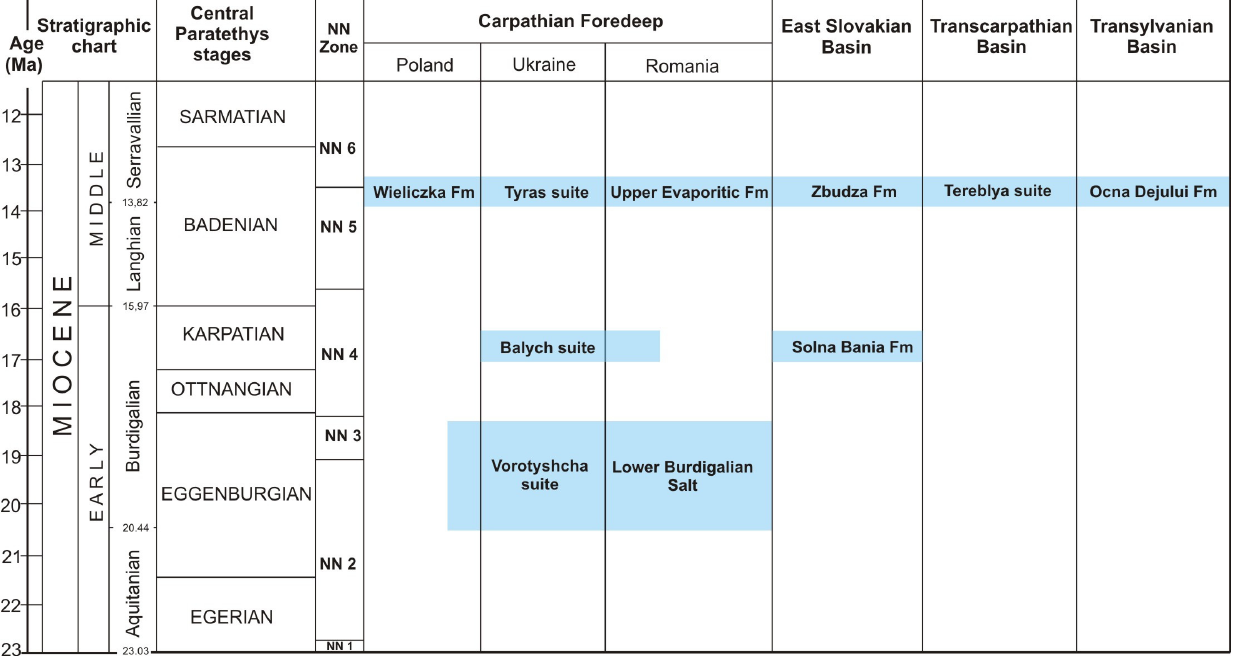
Figure 2. Correlation scheme of salt-bearing formations in Central Paratethys, after [42,43].